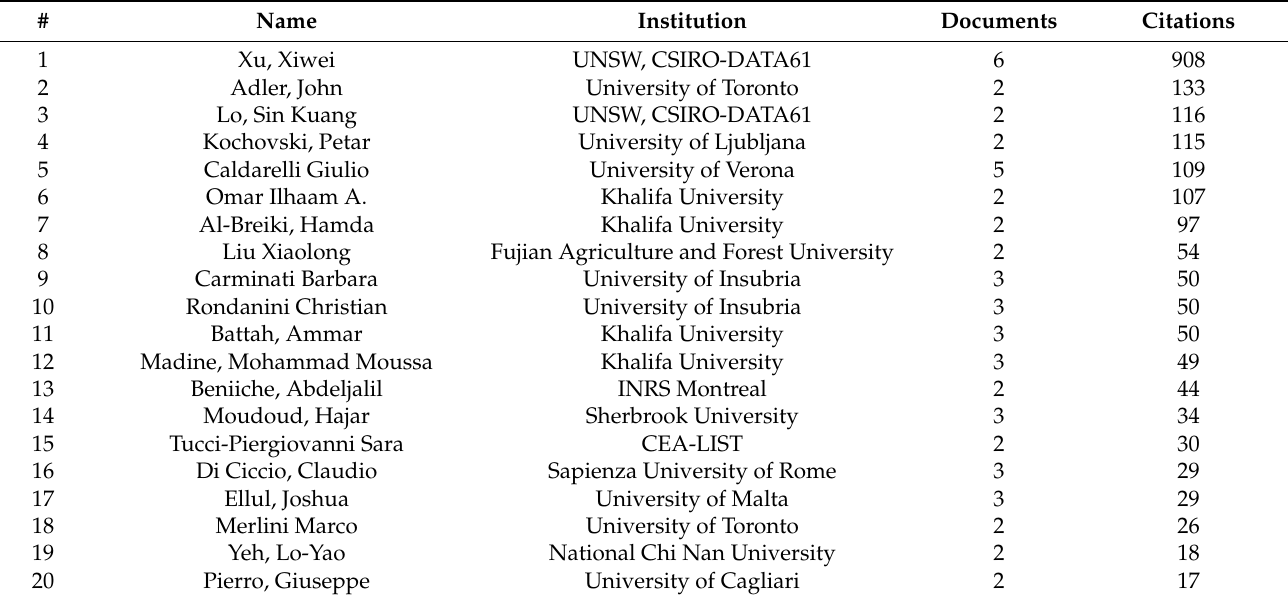
Table 10. Twenty most-cited authors.